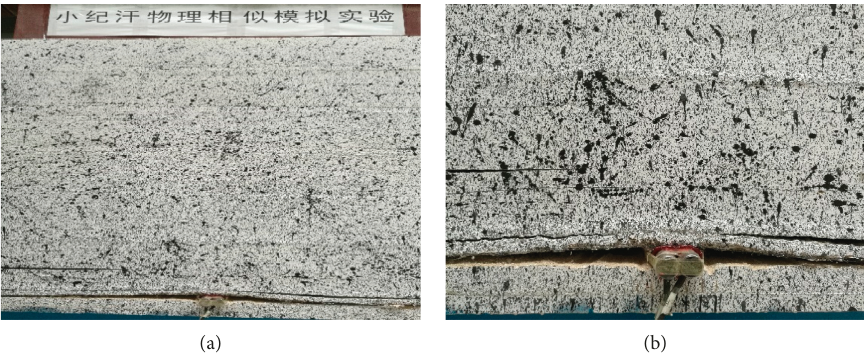
Figure 9: Development figures of roof cracks in No. 11215 working face: the Chinese characters in (a) mean “physical similarity simulation test of Xiaojihan coal mine”.